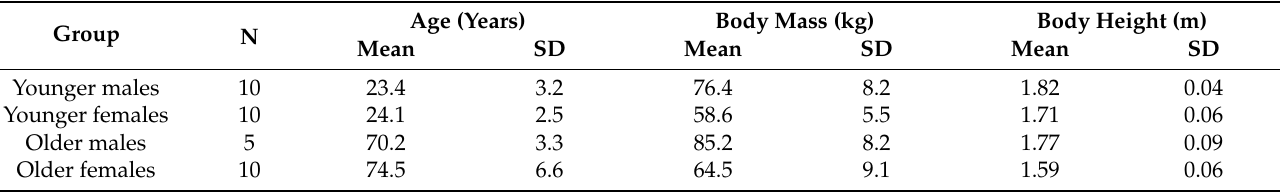
Table 1. Basic participant